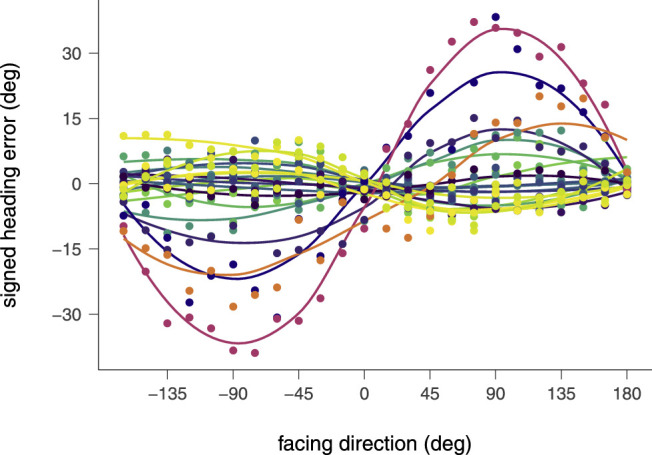
Signed heading errors of all individual participants in the natural articulation-plus-translation condition. Points represent individual means over all trials for a particular facing. Curves present local regressions through individual the data. Participants are color coded.